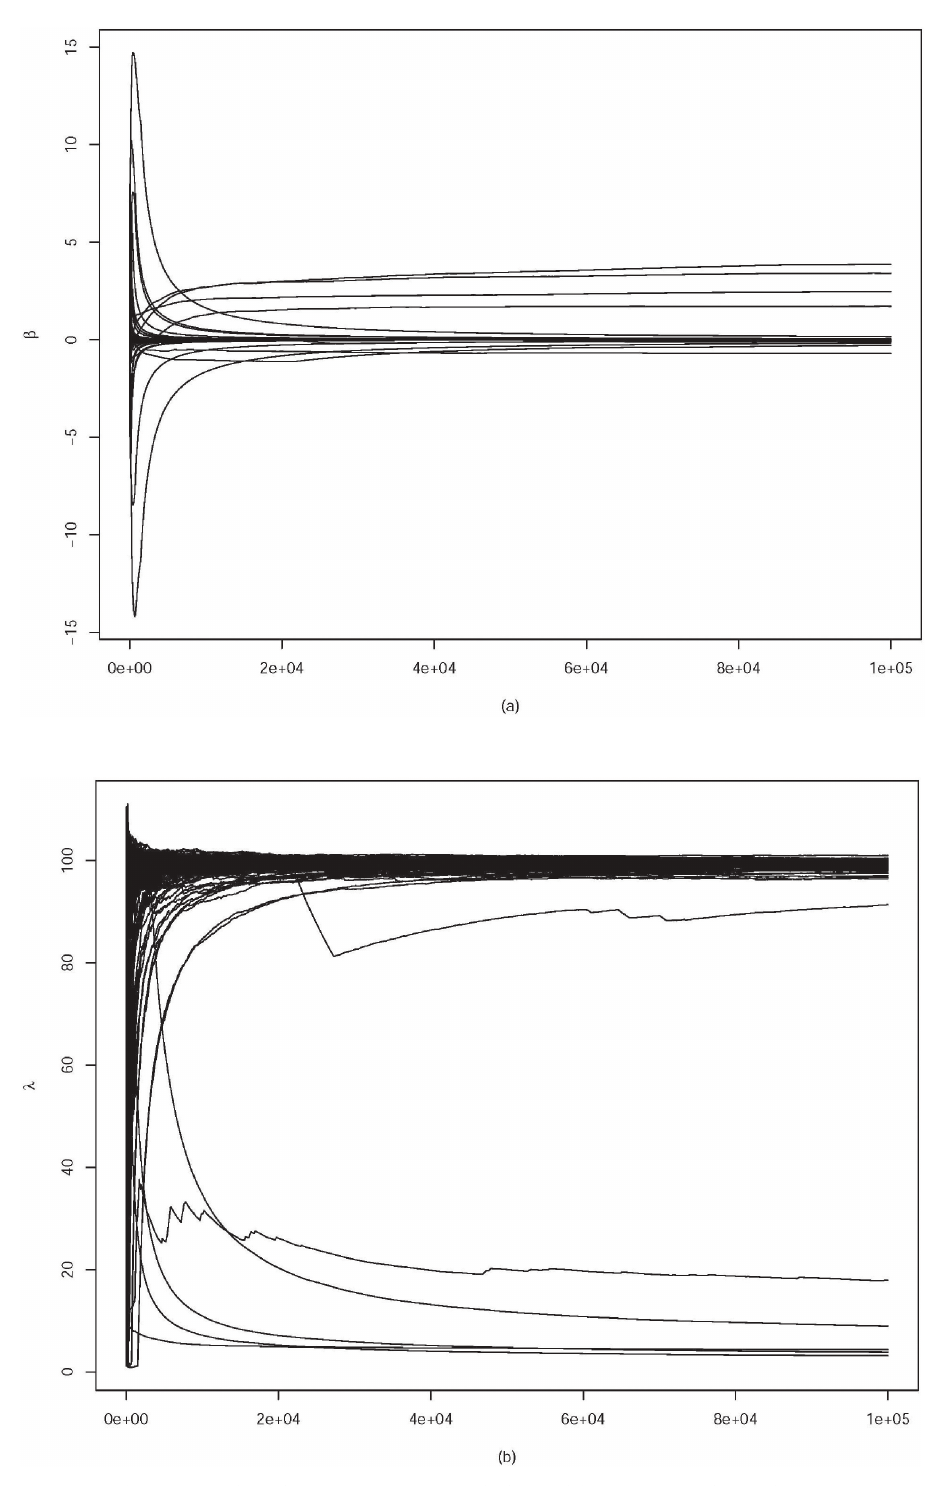
; (b) Tuning parameters ^ l . k k